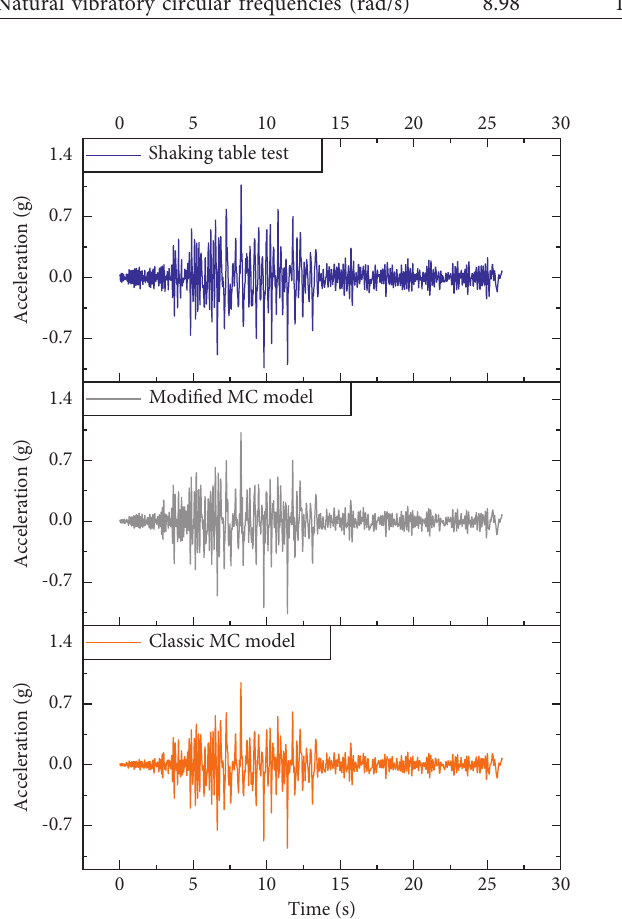
Table 7: First six orders of the natural vibration frequency of the rock material. Natural vibratory circular frequencies